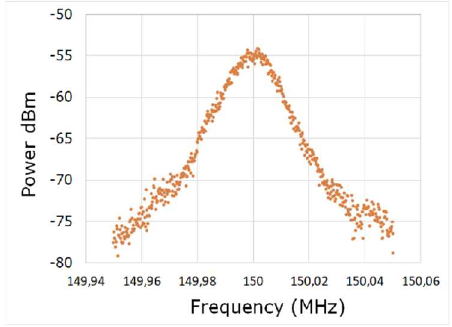
Fig. 4. Short cavity BRL output spectrum .